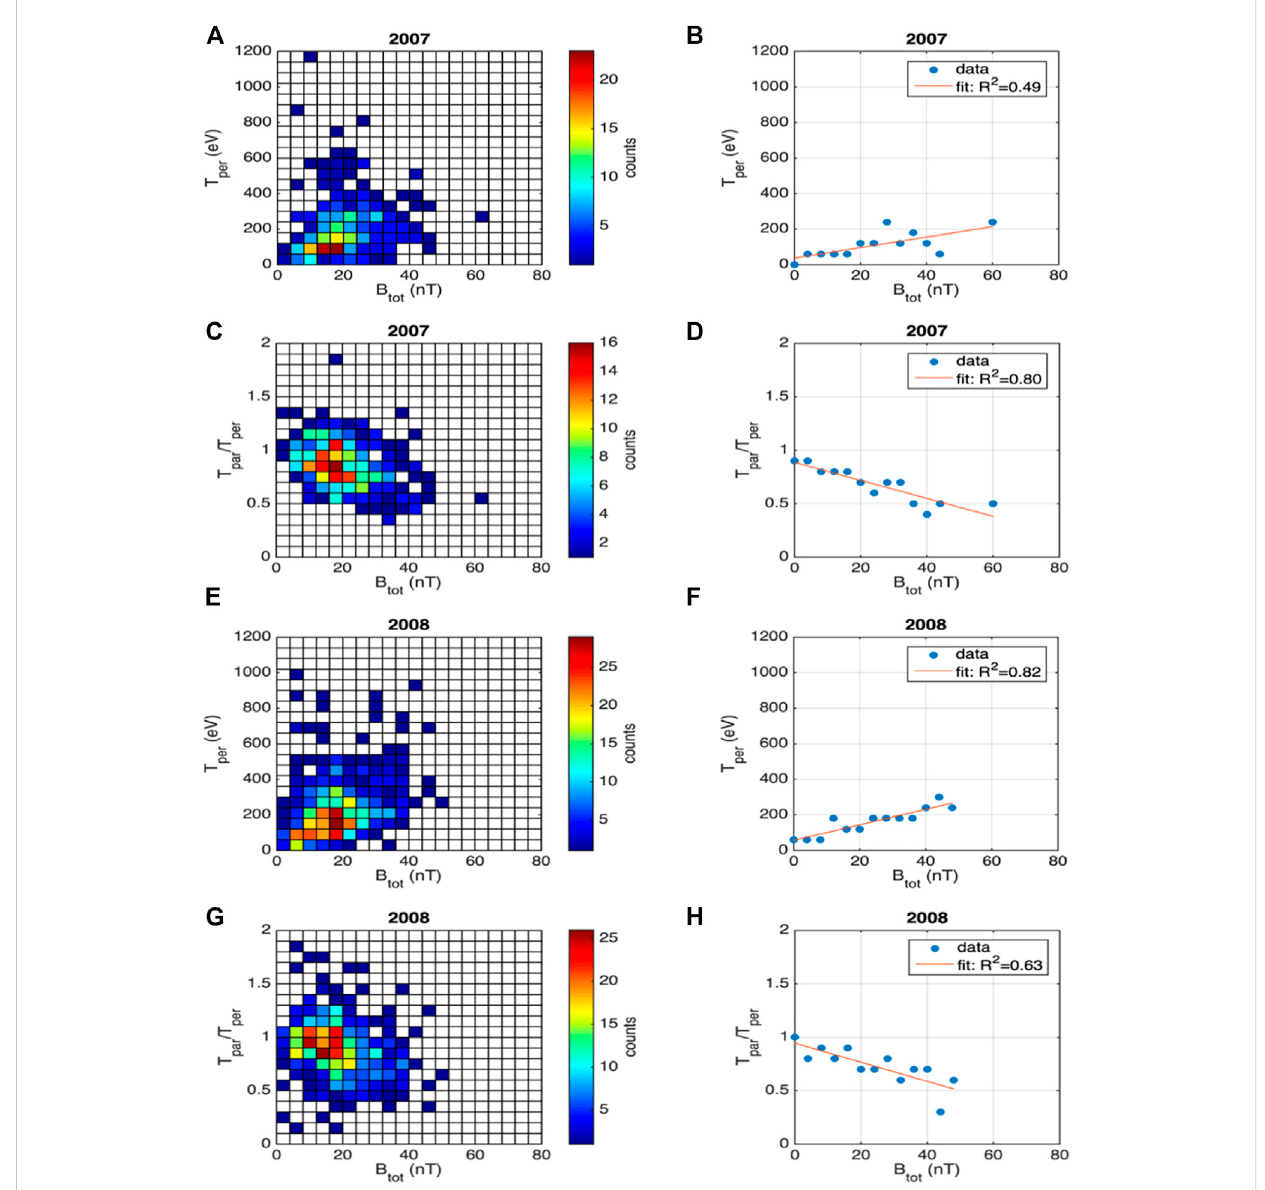
FIGURE 11 Left column: Histograms computed inthe two-dimensional space de fi ned byjet ’ s perpendicularion temperature, T per , and magnetic fi eld intensity, B tot , (A) for 2007, and (E) for 2008 and by the jet ’ s ion temperature anisotropy ( T par / T per ) and magnetic fi eld in the jet (C, G) . Only one value per jet is considered,theoneatmaximumof thedynamicpressure(see Figure 1).Panels intherightcolumn (B, D,F, H) show linear fi tsoftherespective quantities as a function of the local value of the jet magnetic fi eld